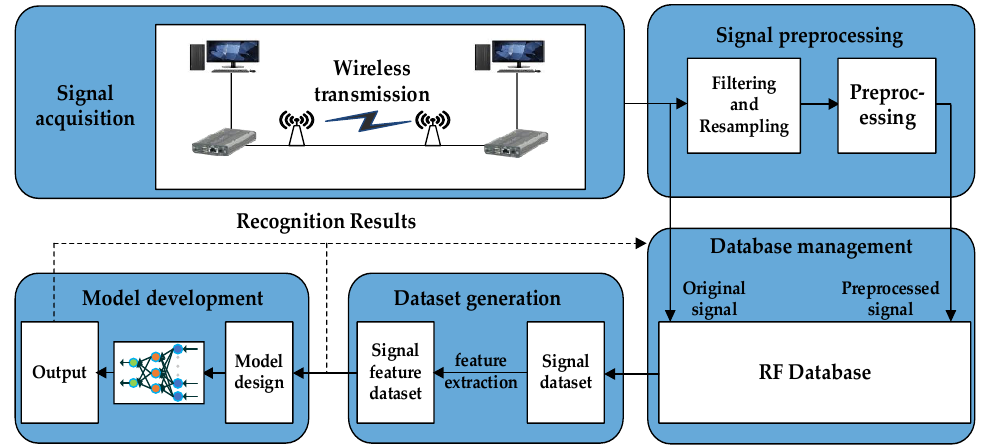
Figure 3. The formation process of the RF database.